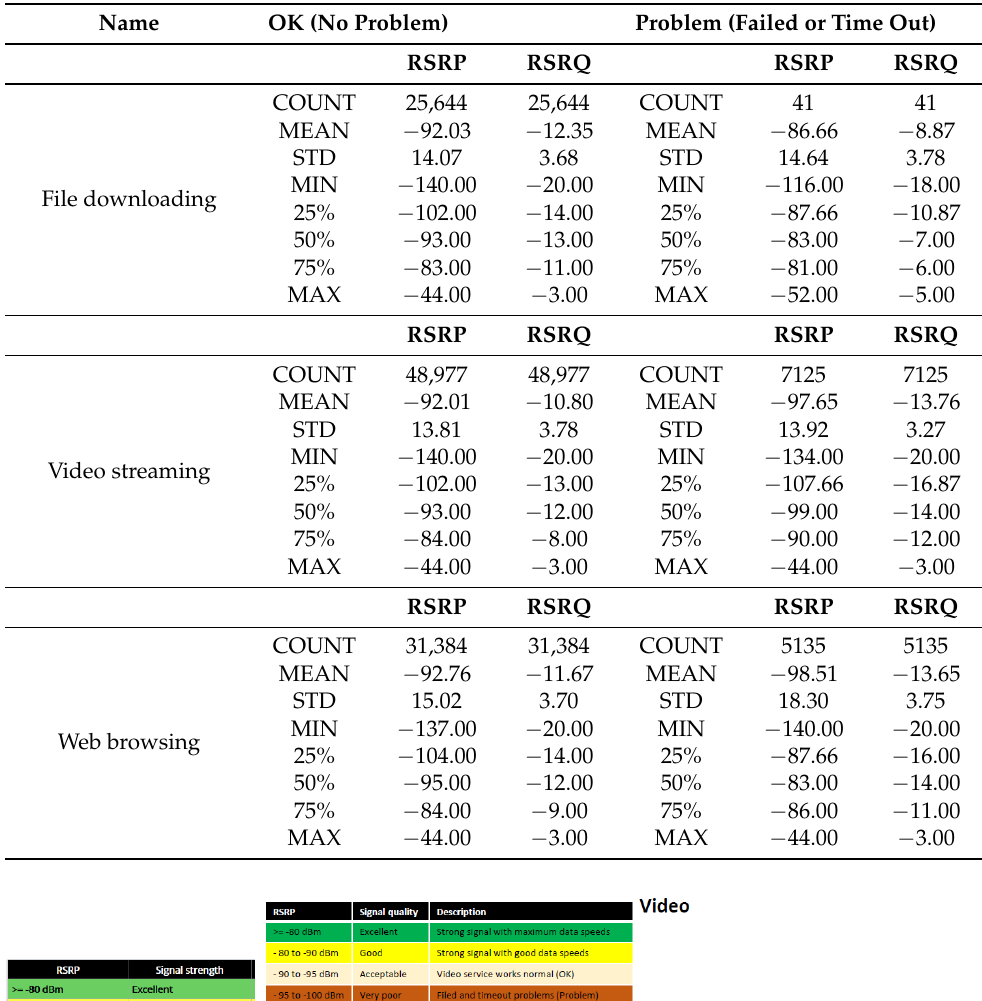
Table 6. Statistics about RSRP and RSRQ for all devices per service.